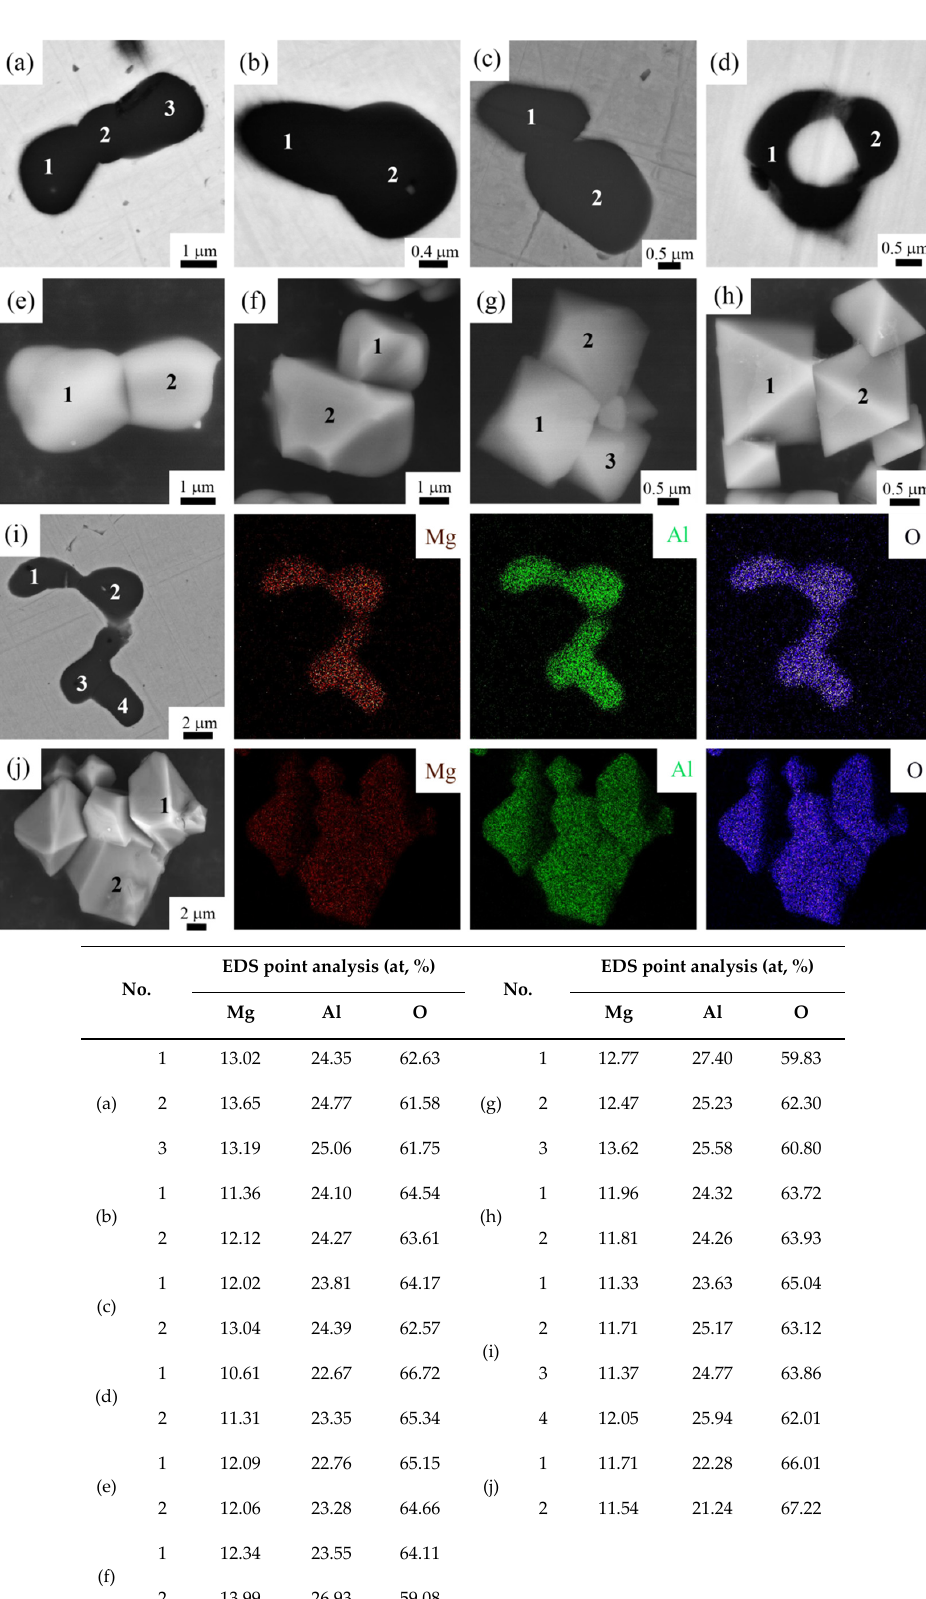
Figure 4. 2D and 3D morphology of the aggregated MgAl 2 O 4 inclusion. ( a ) to ( c ) Long ‐ strip MgAl 2 O 4 ; ( d ) Annular MgAl 2 O 4 ; ( e ), ( f ) Long ‐ strip MgAl 2 O 4 ; ( g ), ( h ) Multi ‐ particle MgAl 2 O 4 ; ( i ) “Z” shape MgAl 2 O 4 with elements mapping; ( j ) Multi ‐ particle MgAl 2 O 4 with elements mapping.